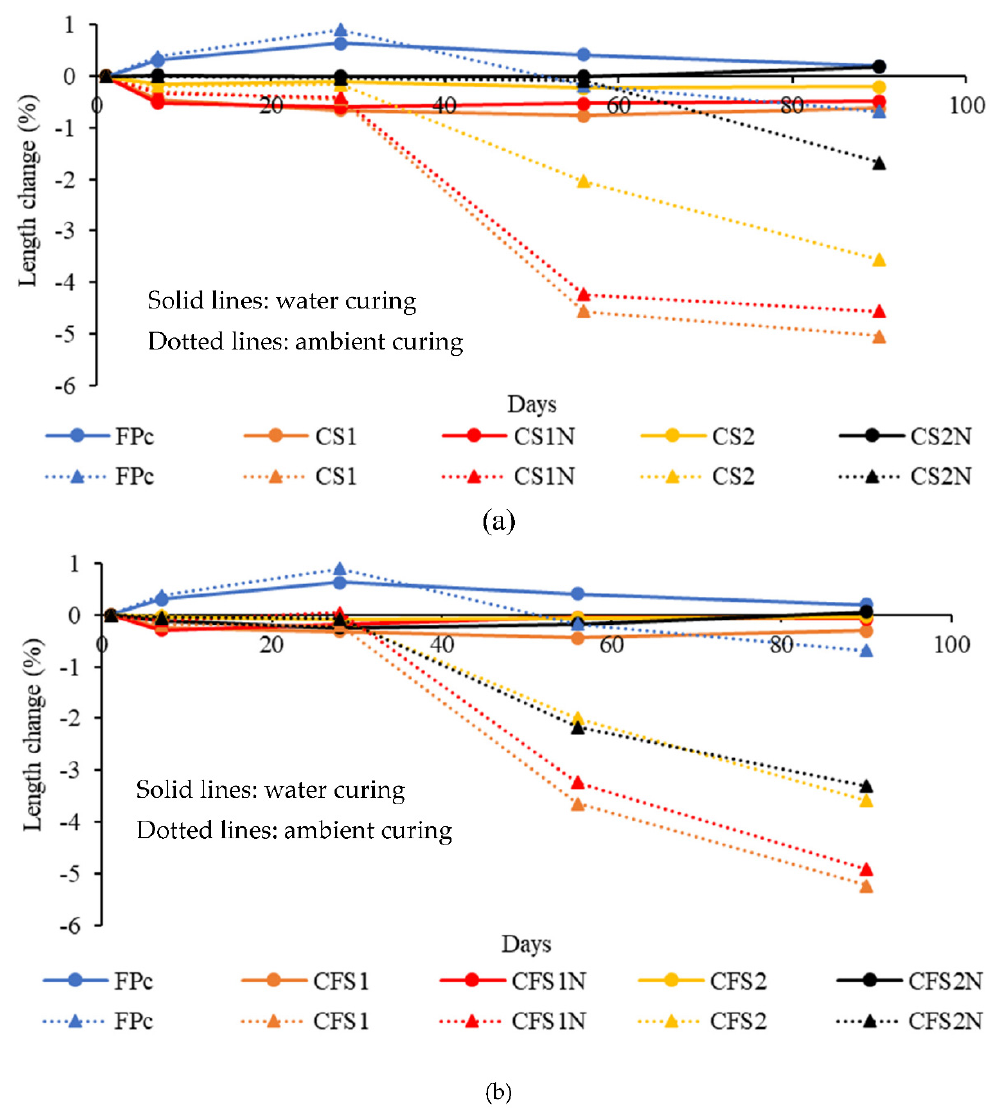
Figure 9. ( a ) Influence of the binary combinations of SCMs on length change. ( b ) Influence of the ternary combinations of SCMs on length change.